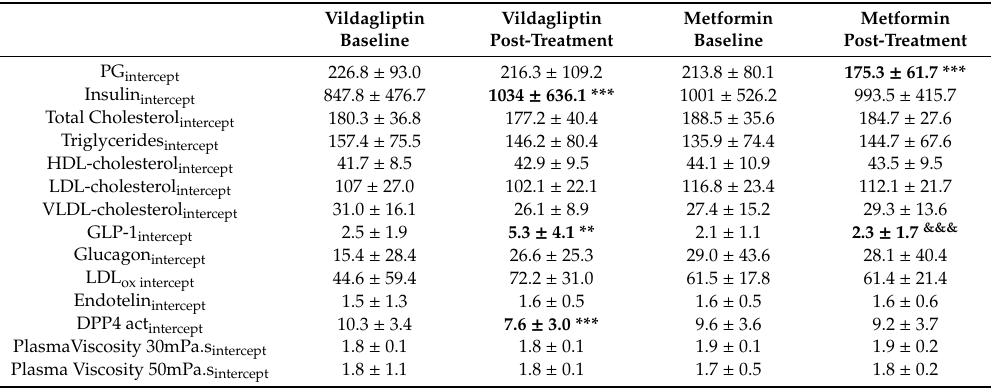
E ff ects of a lipid-rich meal with and without vildagliptin or metformin use on metabolic and inflammatory biomarkers, gastrointestinal peptides, and plasma viscosity during the postprandial